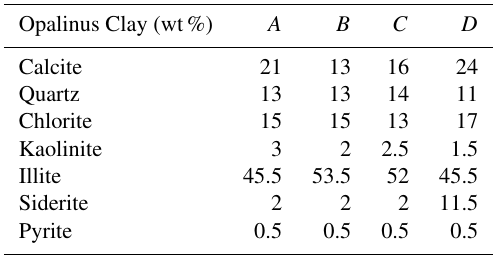
Table 1. Mineralogical composition of four sister Opalinus Clay samples based on X-ray